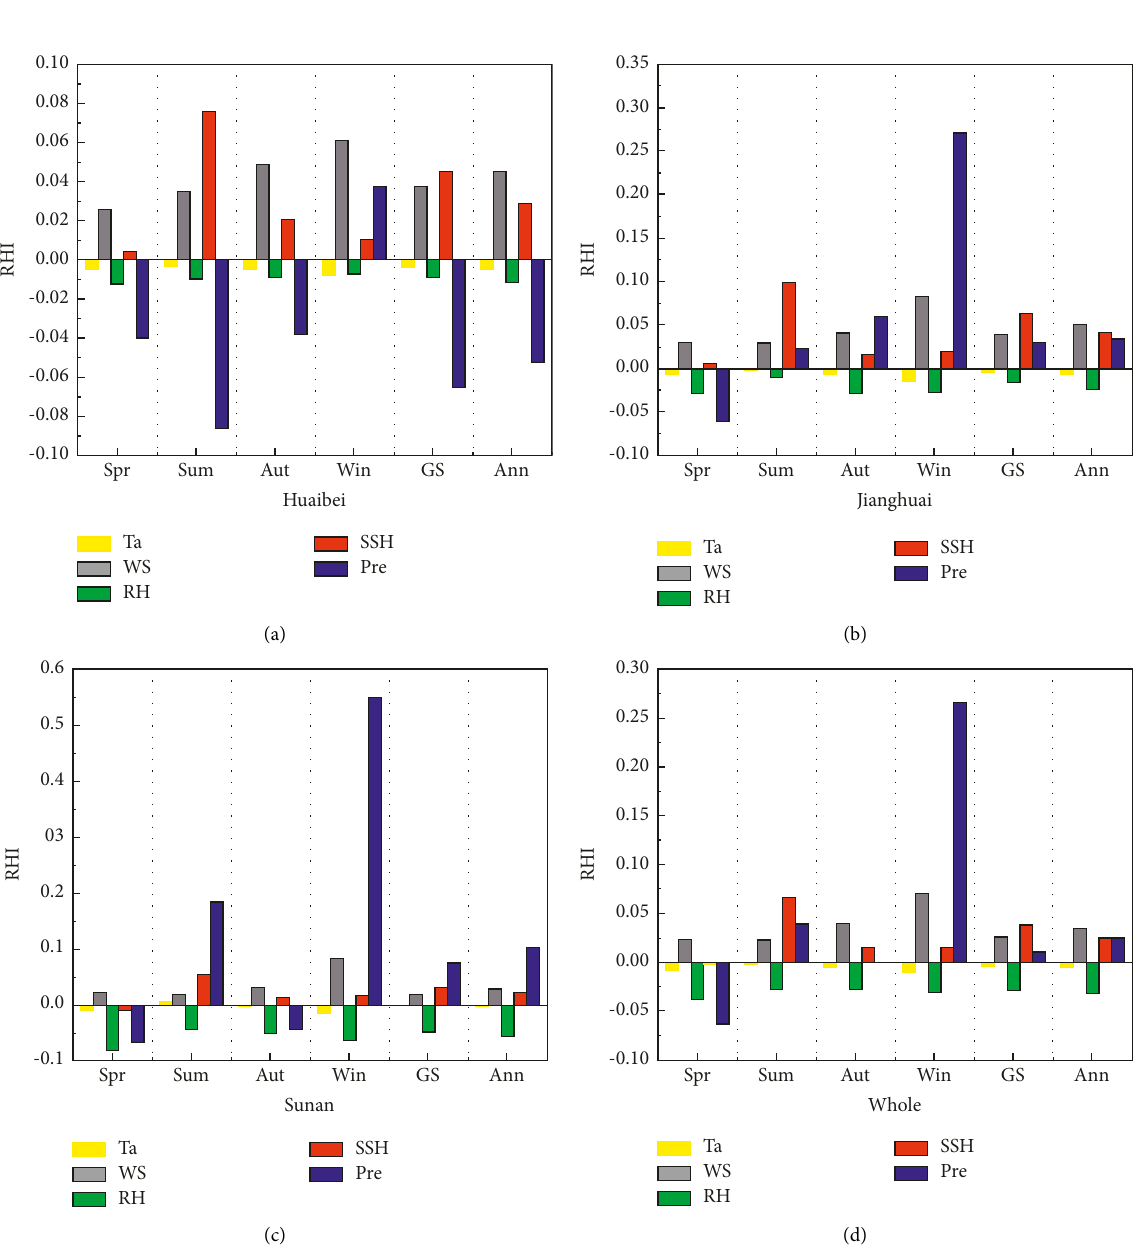
Figure 5: Contributions of five meteorological variables to humidity index (HI) trends at both seasonal and annual scales in (a) Huaibei, (b) Jianghuai, (c) Sunan, and (d) the entire province; T a , WS, SSH, RH, and Pre are daily mean air temperature, wind speed, sunshine hours, relative humidity, and precipitation,